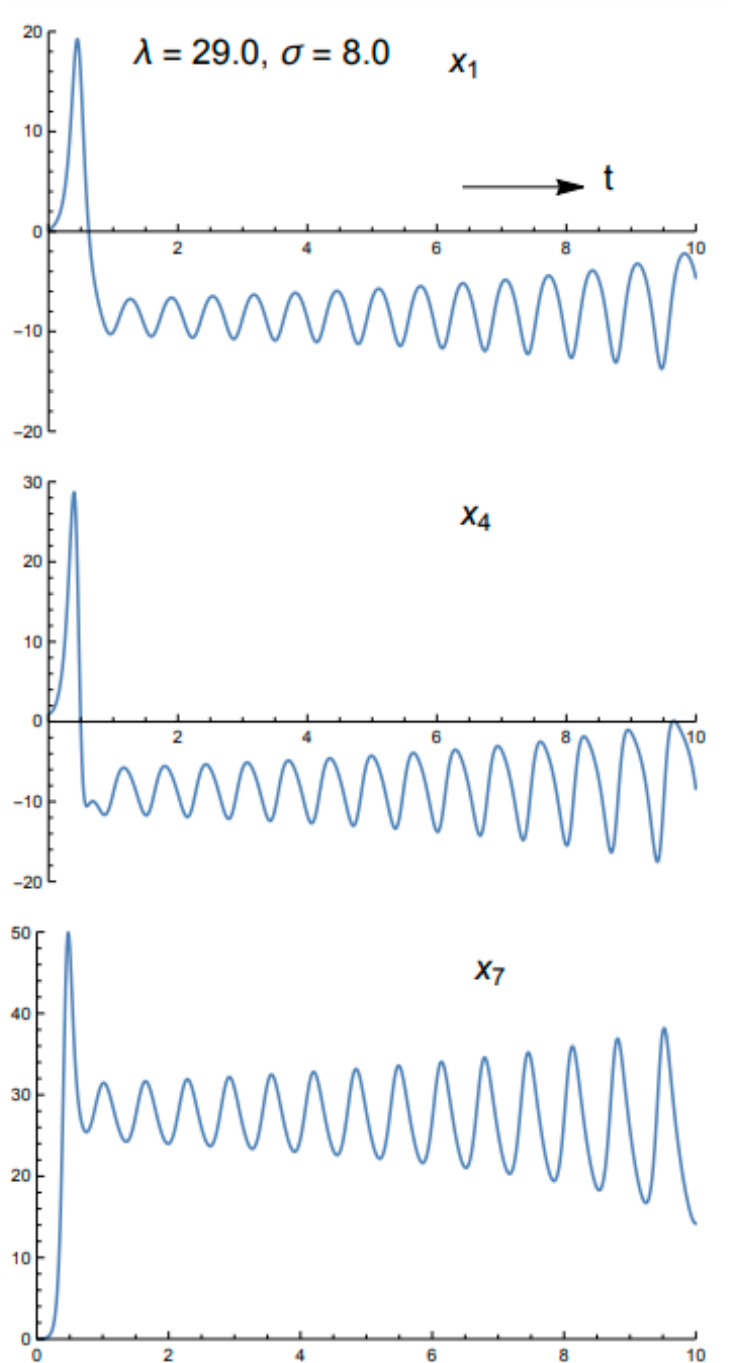
Figure 14. Solution to the amplitude equations for the chaotic regime using L-LOM (3) with guess control given by 𝜆 = 29.0,𝜎 = 8.0 .